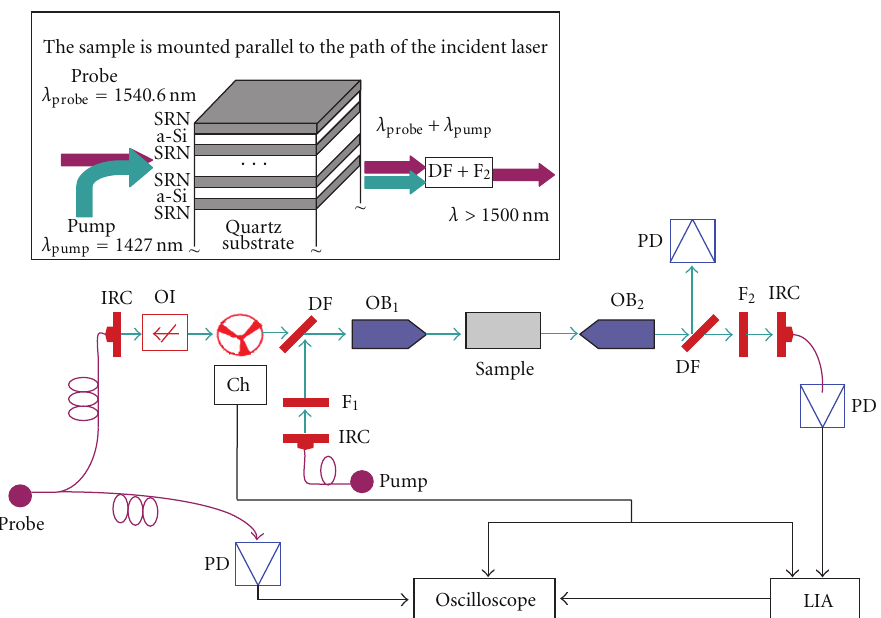
Figure 2: Experimental setup for SRS measurements: pump-Raman laser; IRC: infrared collimator; F 1 : bandpass filter at 1427 nm; probe: ECDL external cavity diode laser (tunable); OI: optical insulator; DF: dichroic filter; OB 1 (OB 2 ): microscope objective lens 50x (20x); F 2 : long pass filter at 1500 nm; Ch: Chopper; PD: optically broadband photodetector; LIA: lock-in amplifier. Black lines represent electrical connections and wiring, green lines represent free-space optical beams, and magenta lines represent optical fiber. The inset shows how the pump and the probe interact with the